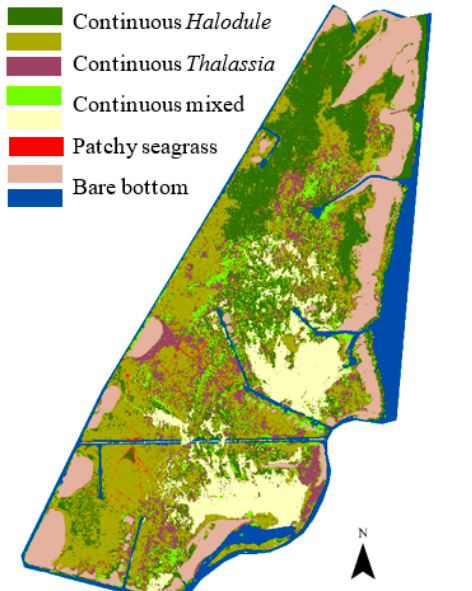
Table 4. Accuracy Matrix of the 3-class classification.